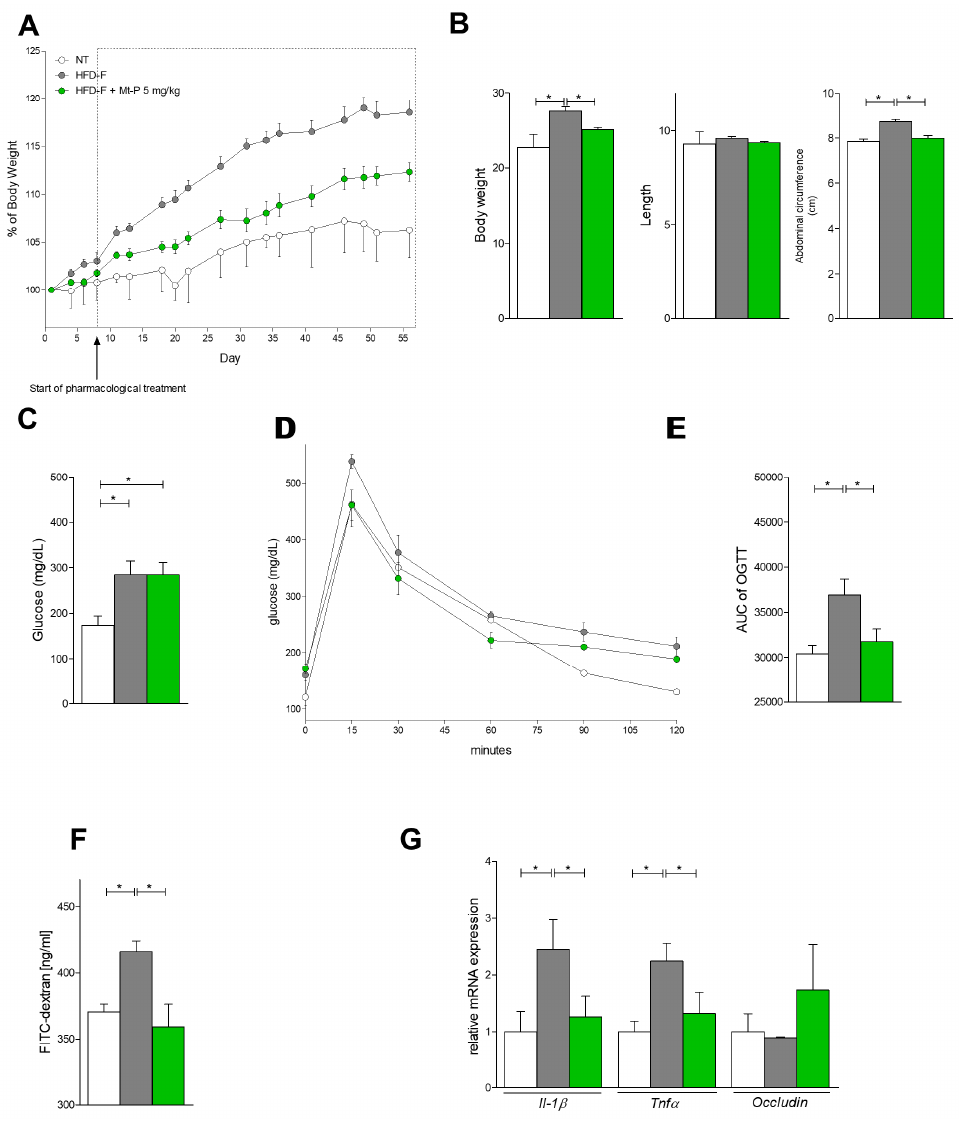
Figure 8. Activation of AhR reduced body weight gain and insulin resistance in mice fed a HFD-F. C57BL / 6 male mice were fed a high fat diet (HFD) and fructose or normal chow diet as described before (see Section 2). ( A ) Changes in body weight (%) assessed weekly. Anthropometrical parameters: ( B ) Body mass index (BMI) measured at the end of the study; ( C ) glucose plasma levels; ( D ) glucose levels in response to OGTT; and ( E ) Air Under the Curve (AUCs) of glucose plasma levels expressed in arbitrary units. Results in intestine: ( F ) Intestinal permeability was measured after 2 weeks of diet with FITC-dextran; and ( G ) quantitative RT-PCR analysis of Il-1 β , Tnf α , and occludin1 . Values are normalized relative to Gapdh mRNA and are expressed as mean ± SEM of six / ten mice per group (NT = 6; HFD-F = 8; HFD-F + Mt-P 5 mg / kg = 10) (* p <